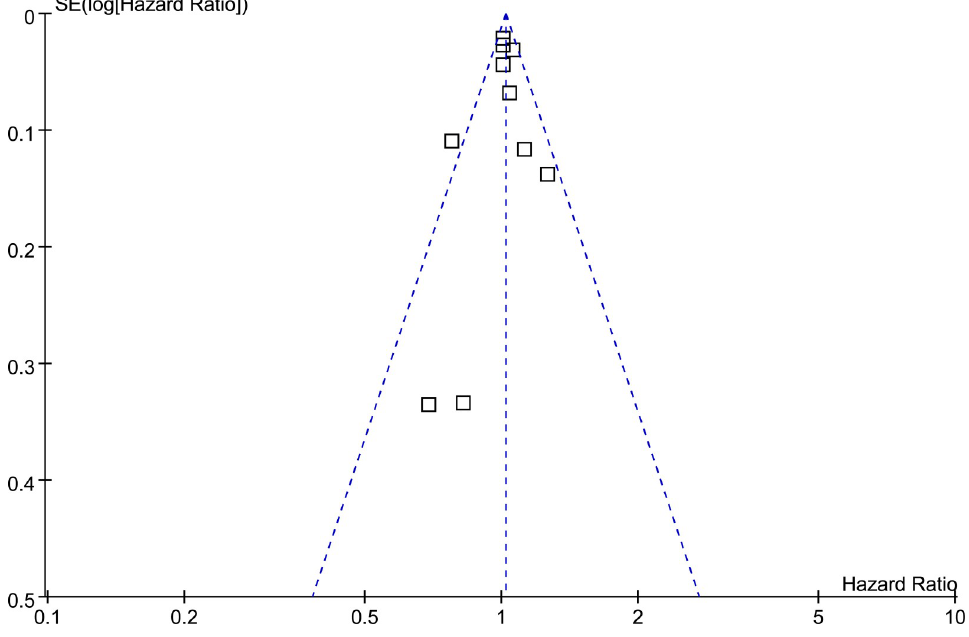
Fig 9. Funnel plots for the meta-analysis of overall association between BB use and OS of lung